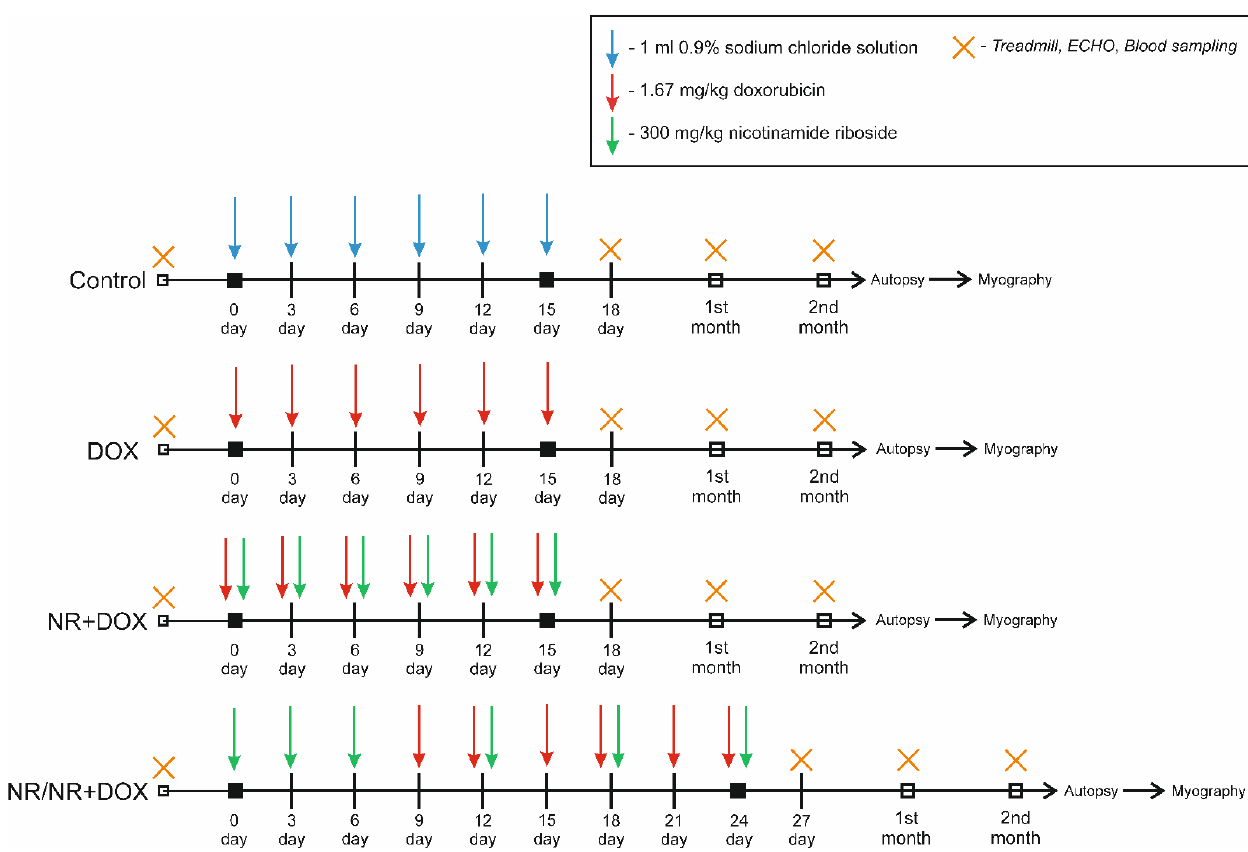
Figure 8. Experimental design.